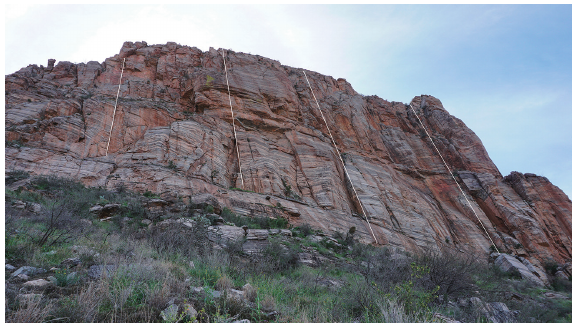
Figure 5: Two primary steeply dipping joint sets taken around the Thimble peak. The joint sets marked in the photo are the one along an ∼ 240 ° azimuth, and the other joint sets are the slope orientation which is nearly east-west